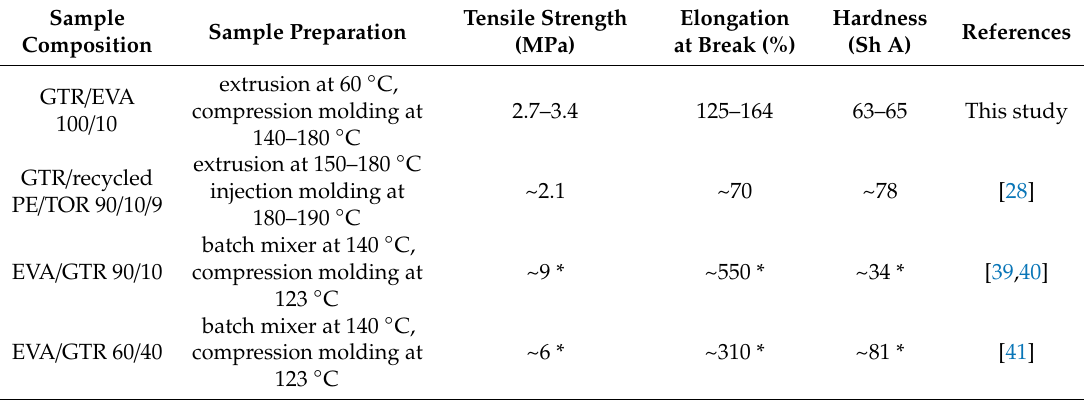
Table 7. Tensile properties of EVA / GTR systems described in